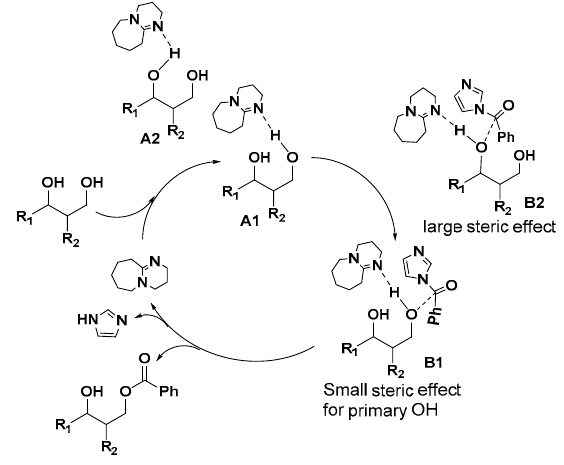
Figure 1. Proposed mechanism for selective benzoylation of primary OH using 1-benzoylimidazole as acylation reagent catalyzed by DBU.